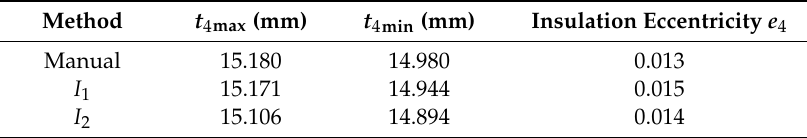
Table 3. Eccentricity measurement of insulation layer in I 1 and I 2 .